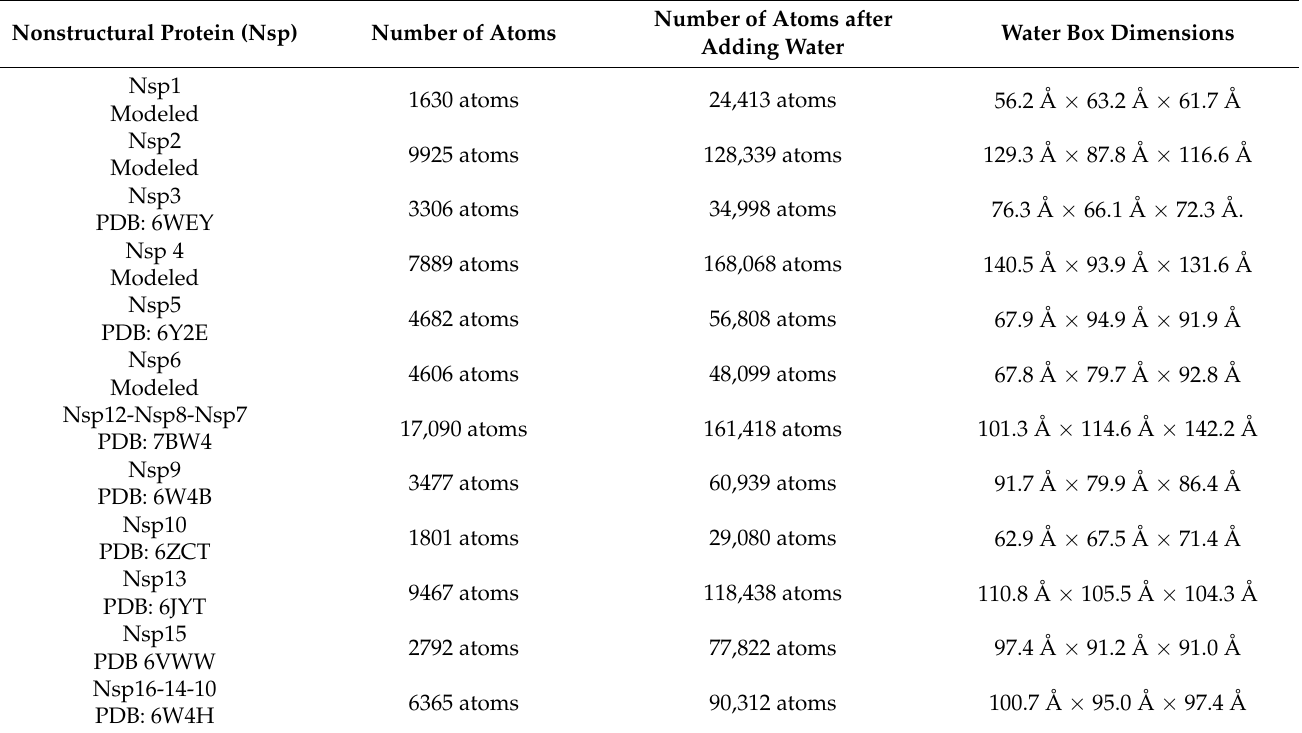
Table 1. Detailed descriptions of number of atoms and water box dimensions for each nonstructural protein (nsps) selected for the